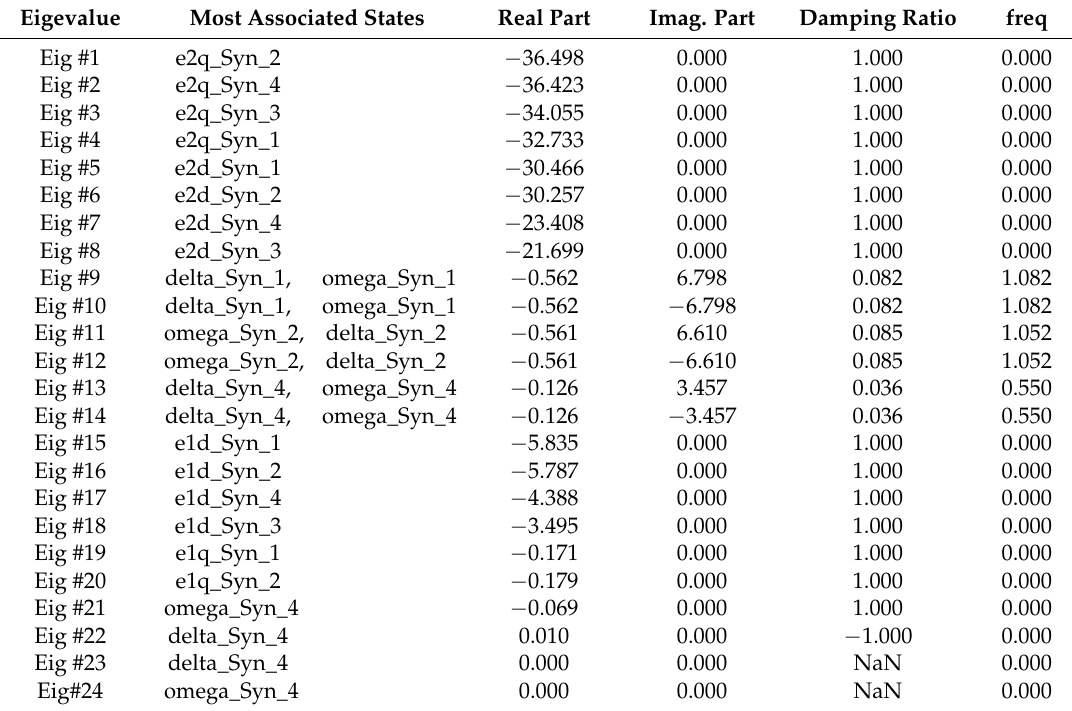
Table 7. The Results of Test Case 2, Obtained by Detailed Modeling of Power System in PSAT